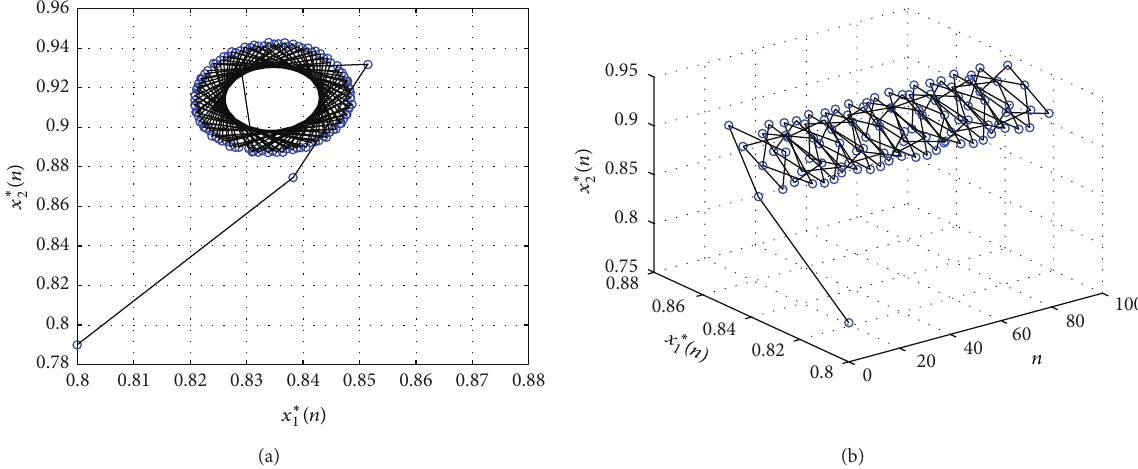
Figure 2: Phase portrait. (a) Two-dimensional phase portrait of 𝑥 ∗ 1 (𝑛) and 𝑥 ∗ 2 (𝑛) with initial values 𝑥 ∗ 1 (−1) = 0.79 and 𝑥 ∗ 1 (0) = 0.80 and (−2) = 0.85 , 𝑥 ∗ (−1) = 0.80 , and 𝑥 ∗ (0) = 0.79 for 𝑛 ∈ [0, 100] . (b) Three-dimensional phase portrait of 𝑛, 𝑥 ∗ 𝑥 ∗ 2 2 2 initial values for 𝑛 ∈ [0,100] .